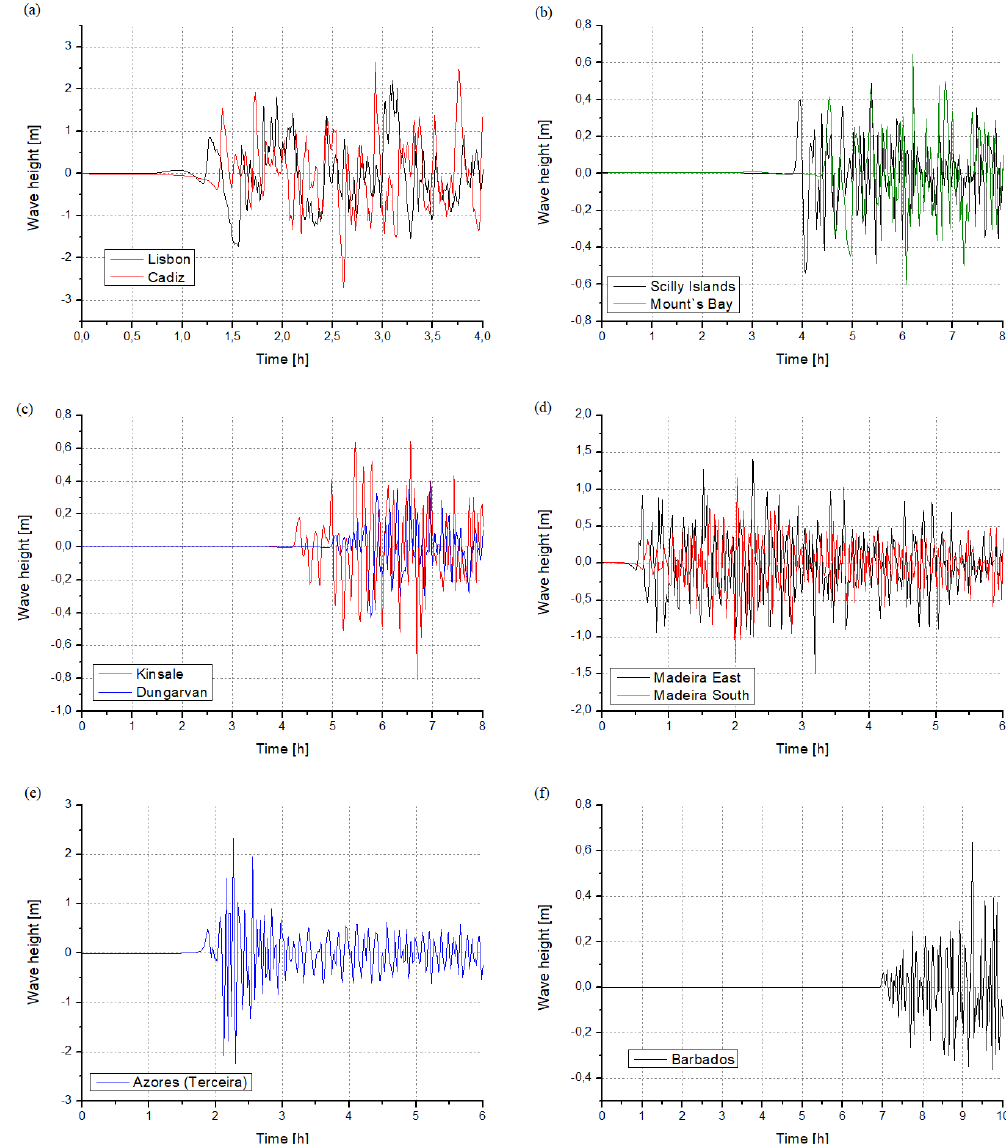
Figure 7. VTG records for hypothesis B at the coordinates of the locations presented in Table